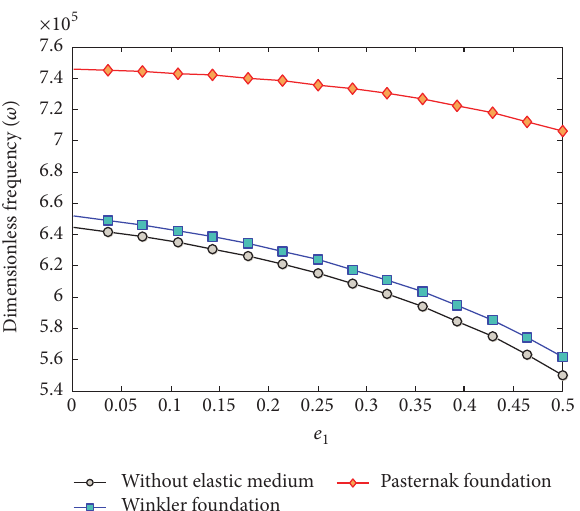
Figure 8: Effect of material properties on dimensionless natural